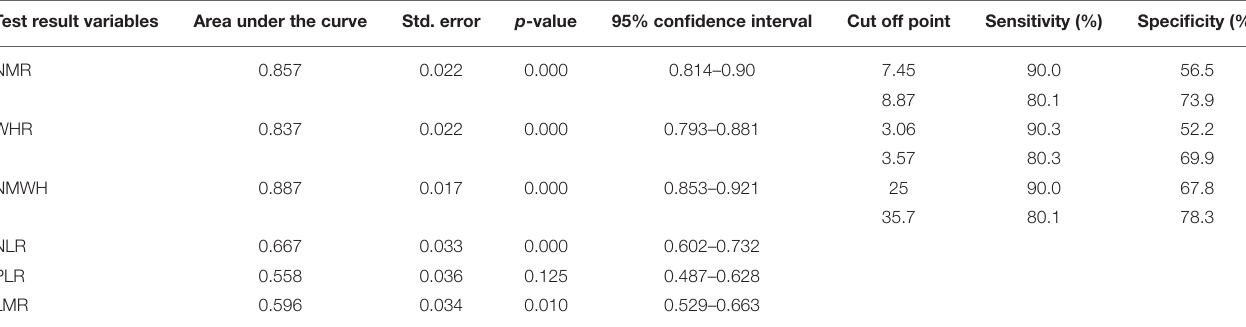
TABLE 3 | Receiver operating characteristic (ROC) curve analysis of predictive scores and cut-off points. Test result